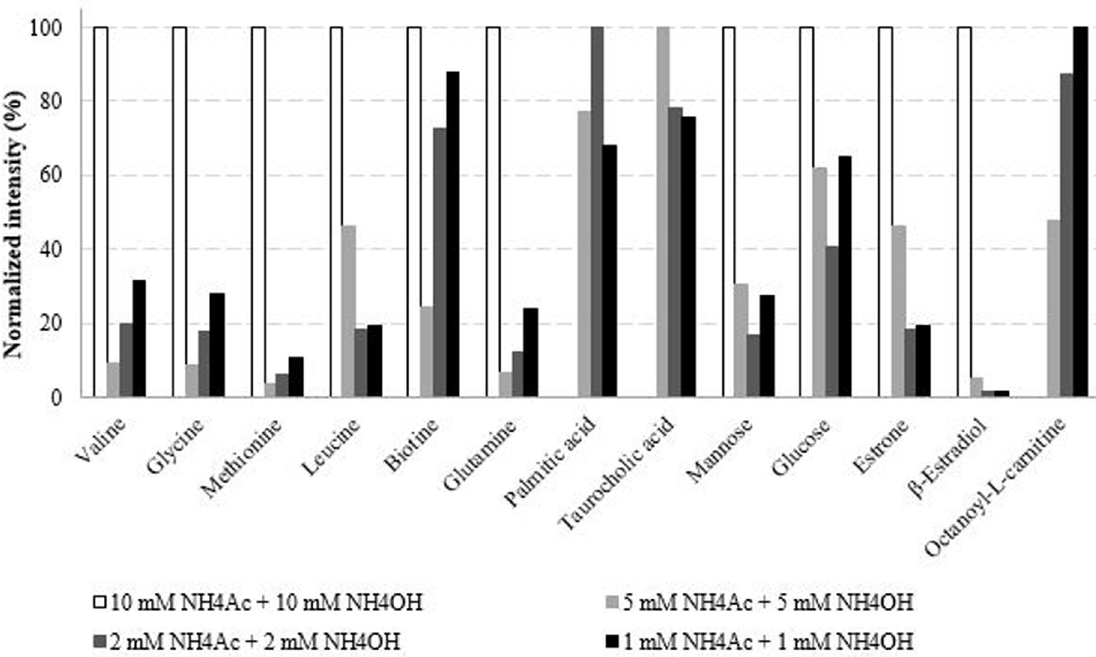
Fig 3. Normalized intensities of targeted metabolites analyzed by LC(HILIC)-(ESI-)-HRMS using various concentrations of (NH 4 F + NH 4 OH) salts in the mobile phase (results obtained after extraction of 50 mg of fish spiked at 500 μ g/L).